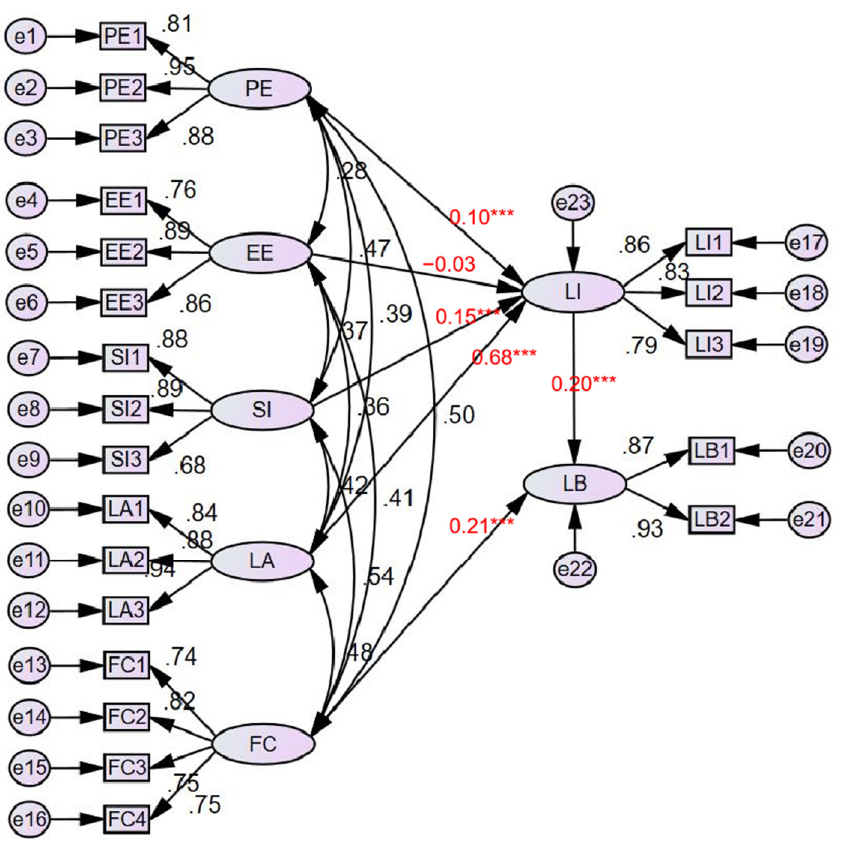
Figure 2. Model analysis diagram of BIM learning behavior research. Note: ** means less than 0.001 < p < 0.005, and *** means less than p < 0.001.